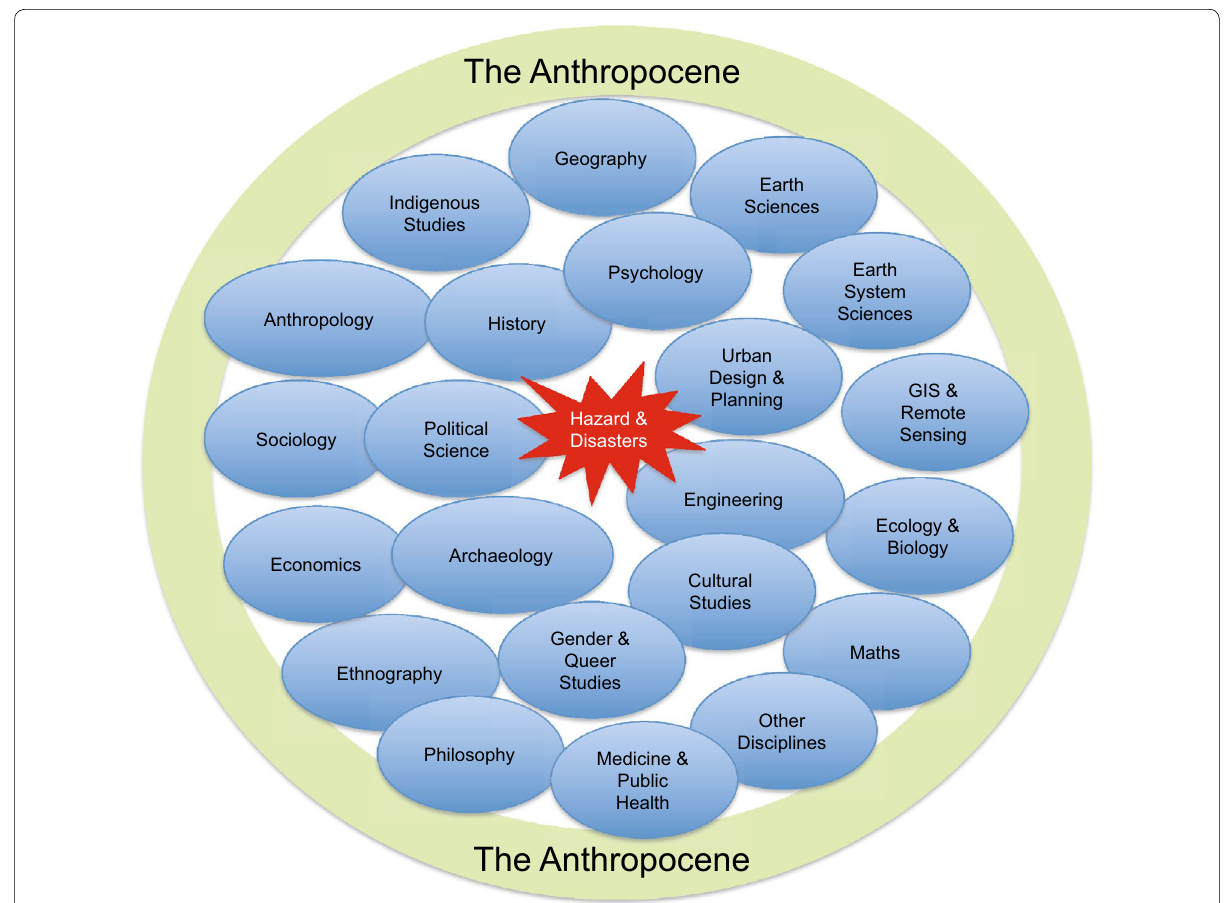
Fig. 2 Wide range of disciplines contribute to the study of hazards and disasters and all have contributions to make to help us understand the significance of possible hazards and disasters in the